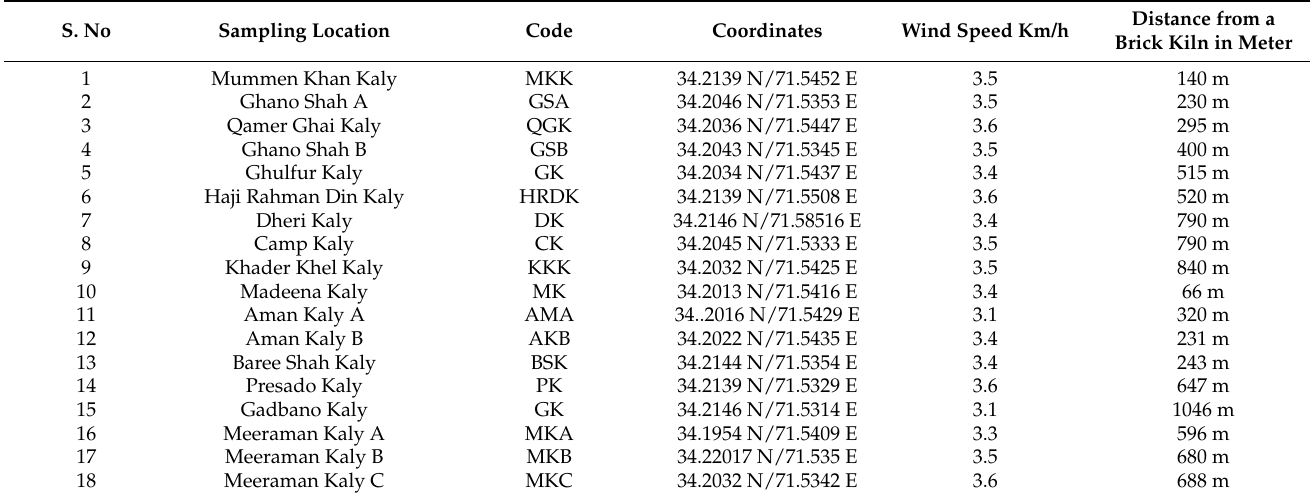
Table 1. Location of sampling points and distances from brick